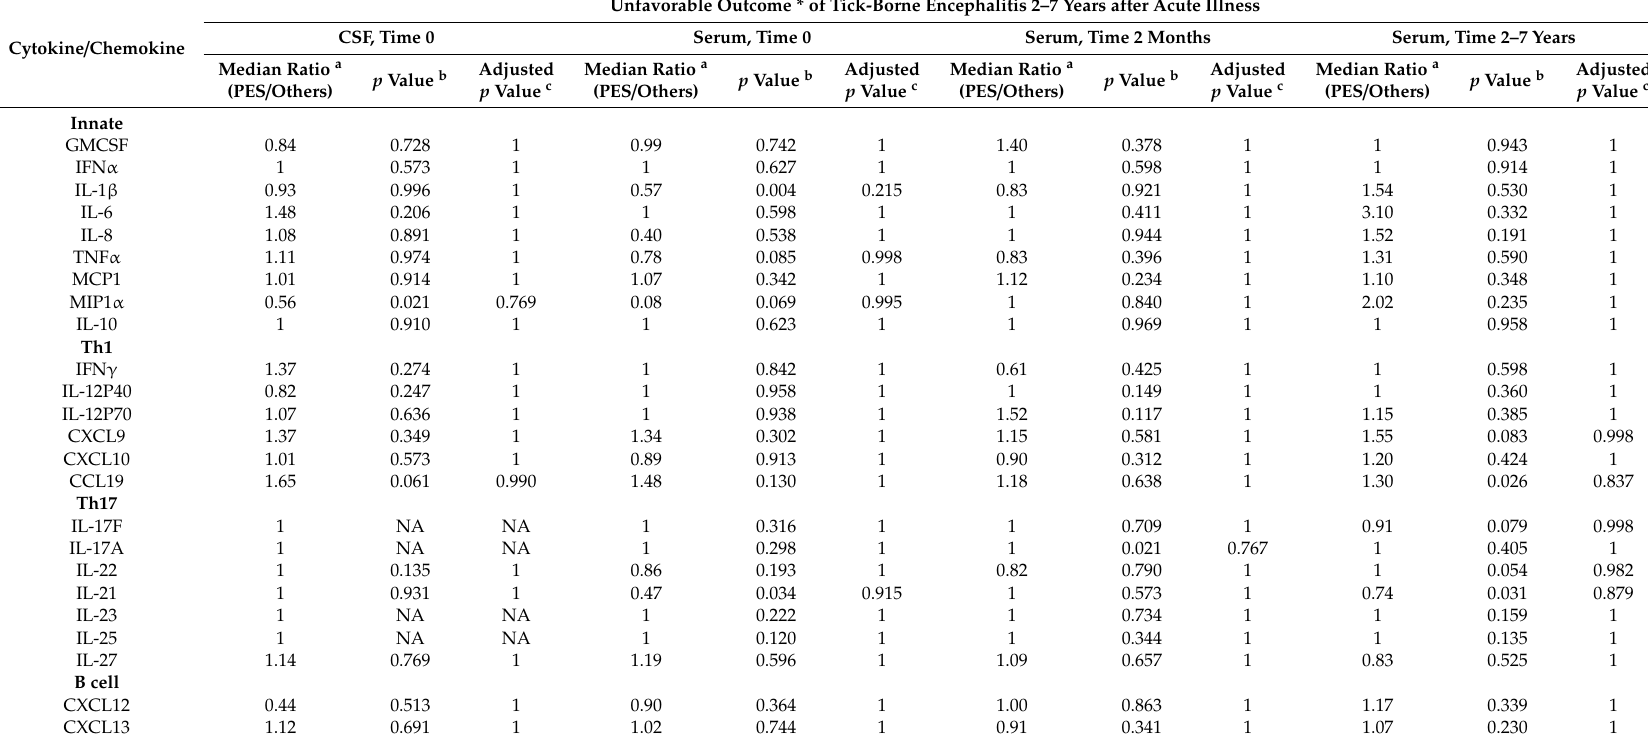
Table 3. Correlation of cytokine and chemokine levels obtained at the time of acute illness, 2 months later, and 2–7 years later with the outcome of tick-borne encephalitis 2–7 years after acute